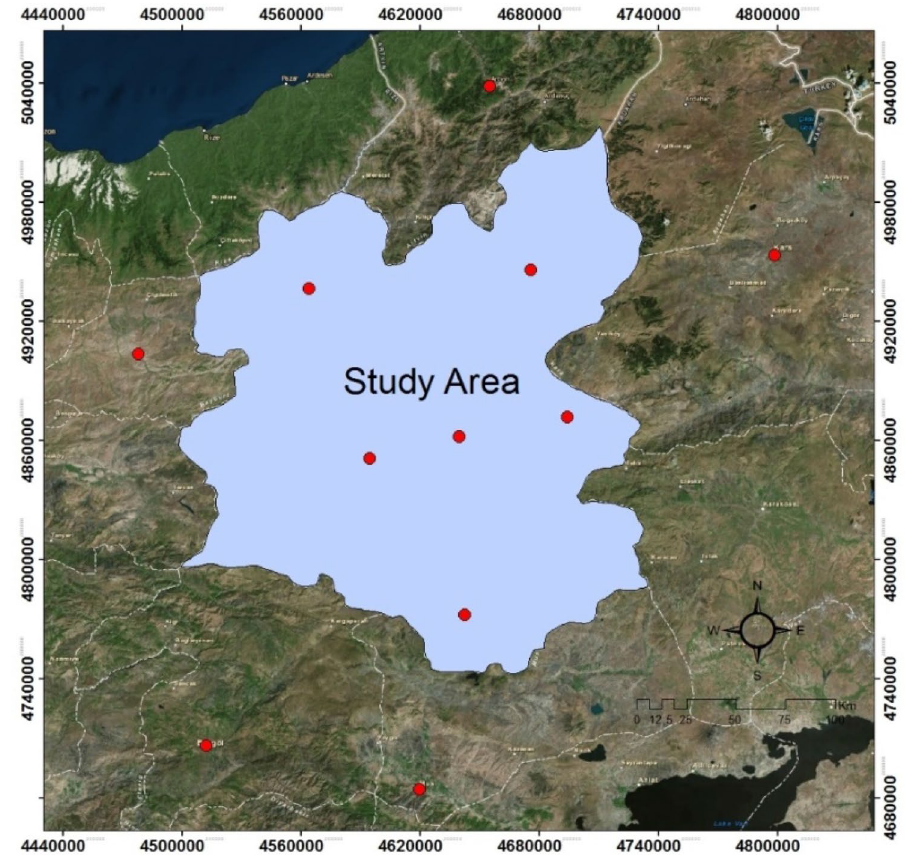
Figure 14. Sampling points used to create pressure and humidity